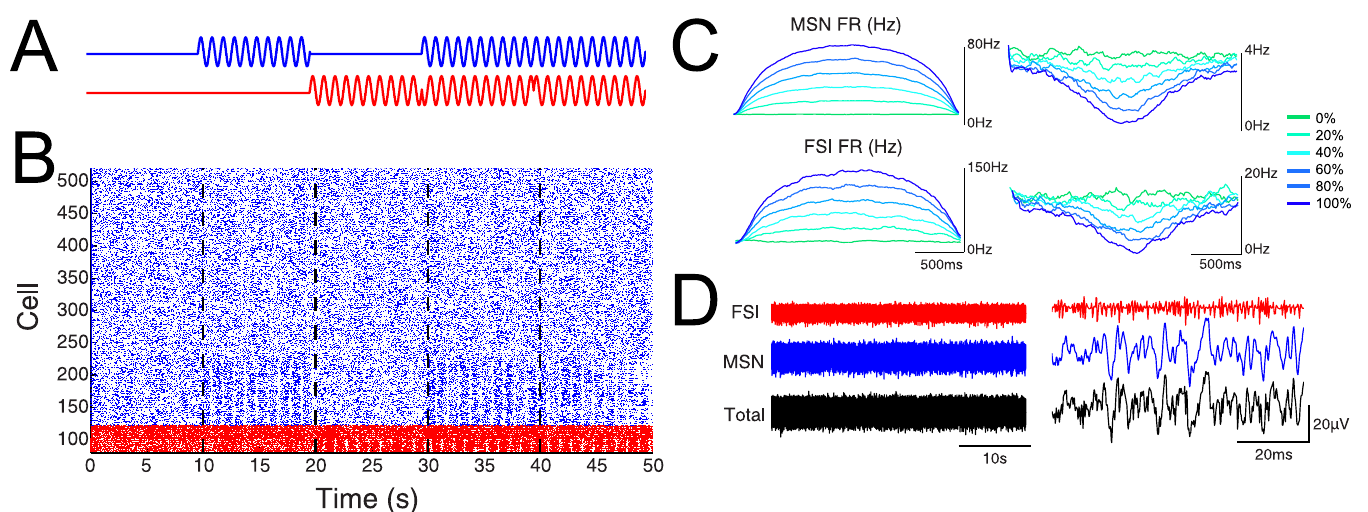
Fig 5. Modeling the spiking contribution to high frequency activity. A) Experimental design. Blue and red traces represent the times at which the firing rate of MSNs and FSIs were modulated, respectively. B) Raster plots of a subset of MSNs (blue) and FSIs (red) used in the simulation. In this example, 20% of neurons were modulated. C) Instantaneous population firing rates for MSNs and FSIs when different proportions of neurons were modulated. The left shows population firing rates as a function of the proportion of neurons modulated when the sinusoidal input is positive (so that the input increases firing rates). The right panel shows population firing rates when the input is negative (so that the input decreases firing rates). Traces are color-coded based on the proportion of neurons that were driven by the input. D) Aggregate high frequency activity derived from the total spiking of all neurons used in the model. FSI and MSN contributions as well as the total activity for the duration (left) and a subset (right) of the recording.